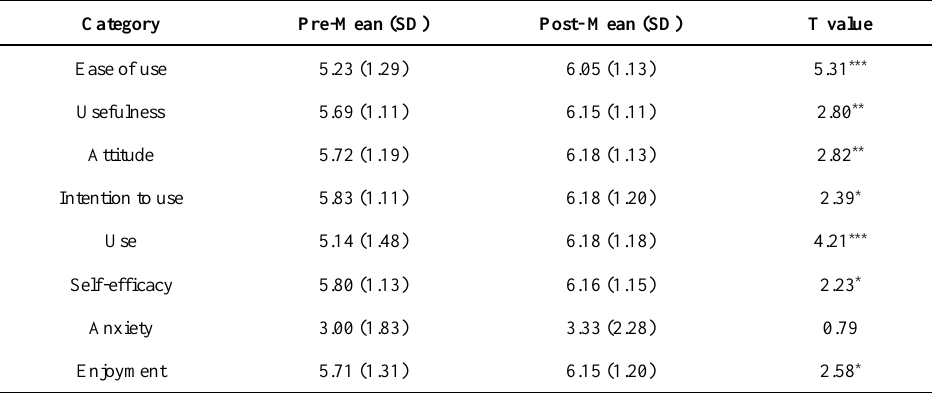
Table 2. Means, standard deviations, T value of the scores of the different constructs of acceptance of digital tools for mathematics teaching